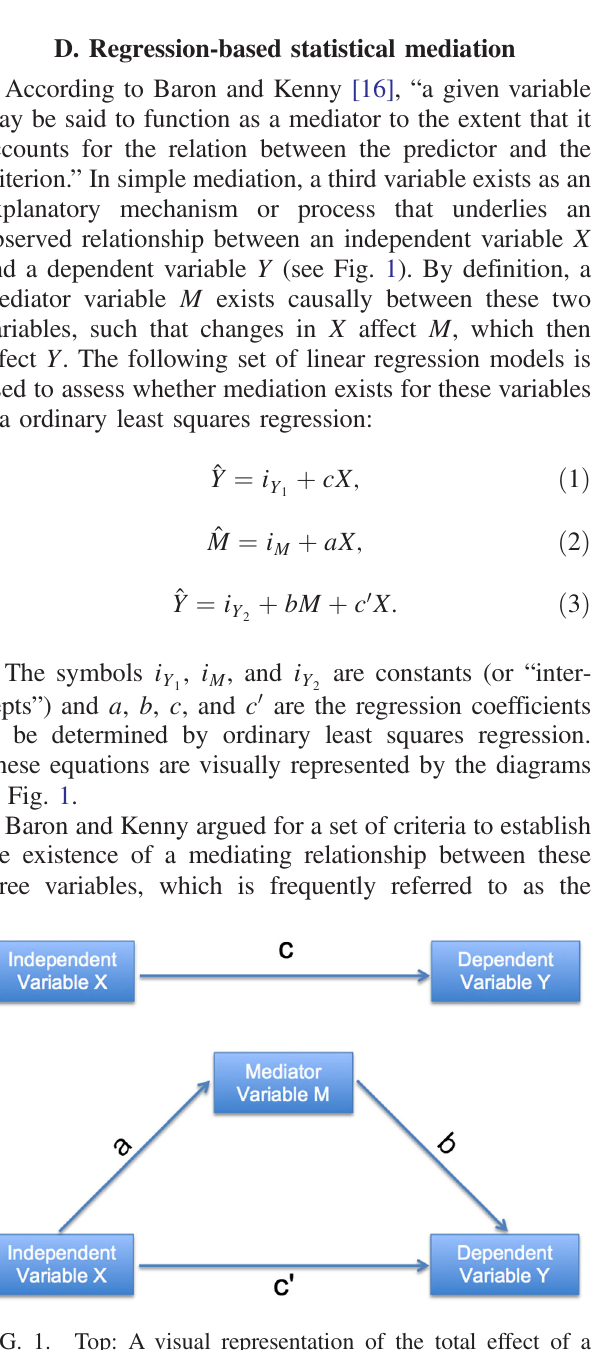
FIG. 1. Top: A visual representation of the total effect of a simple mediation model. Mathematically, this is shown in Eq. (1). Bottom: A visual representation of the indirect and direct effects of a simple mediation model. Mathematically, this is shown in Eqs. (2) and